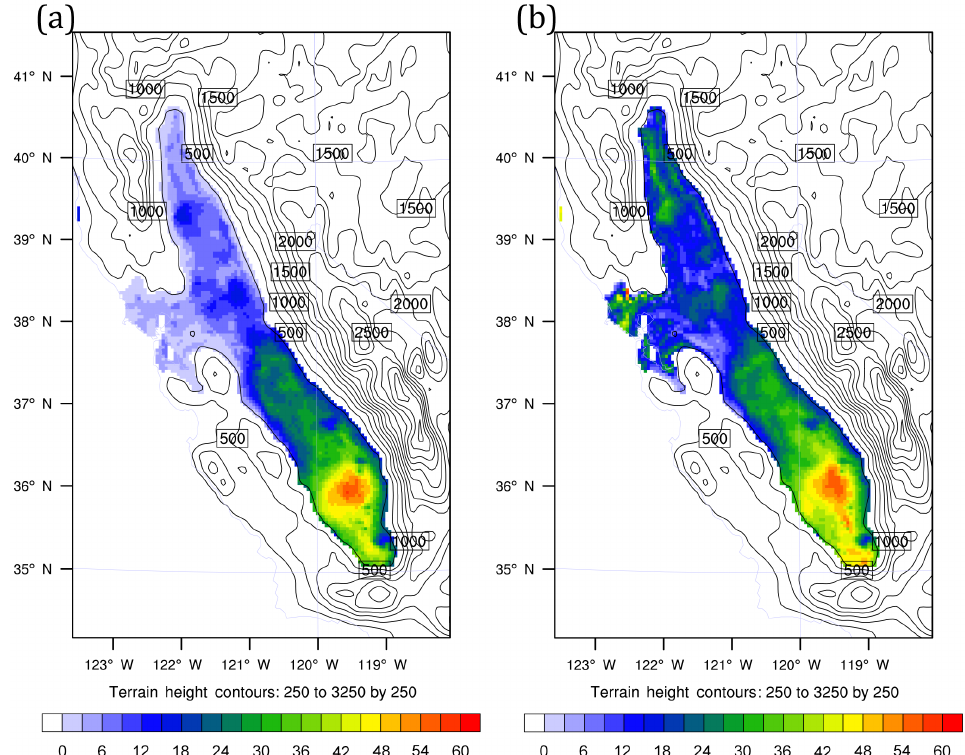
Figure 10. N CCN /N CN ratio for (a) S_ ARon_CRmod (source-oriented experiment) and (b) I_ARon_CRmod (internally mixed experiment) averaged within the first five model layers. The ratio is hourly average during 16 to 18 January 2011. Contours are terrain heights in m.